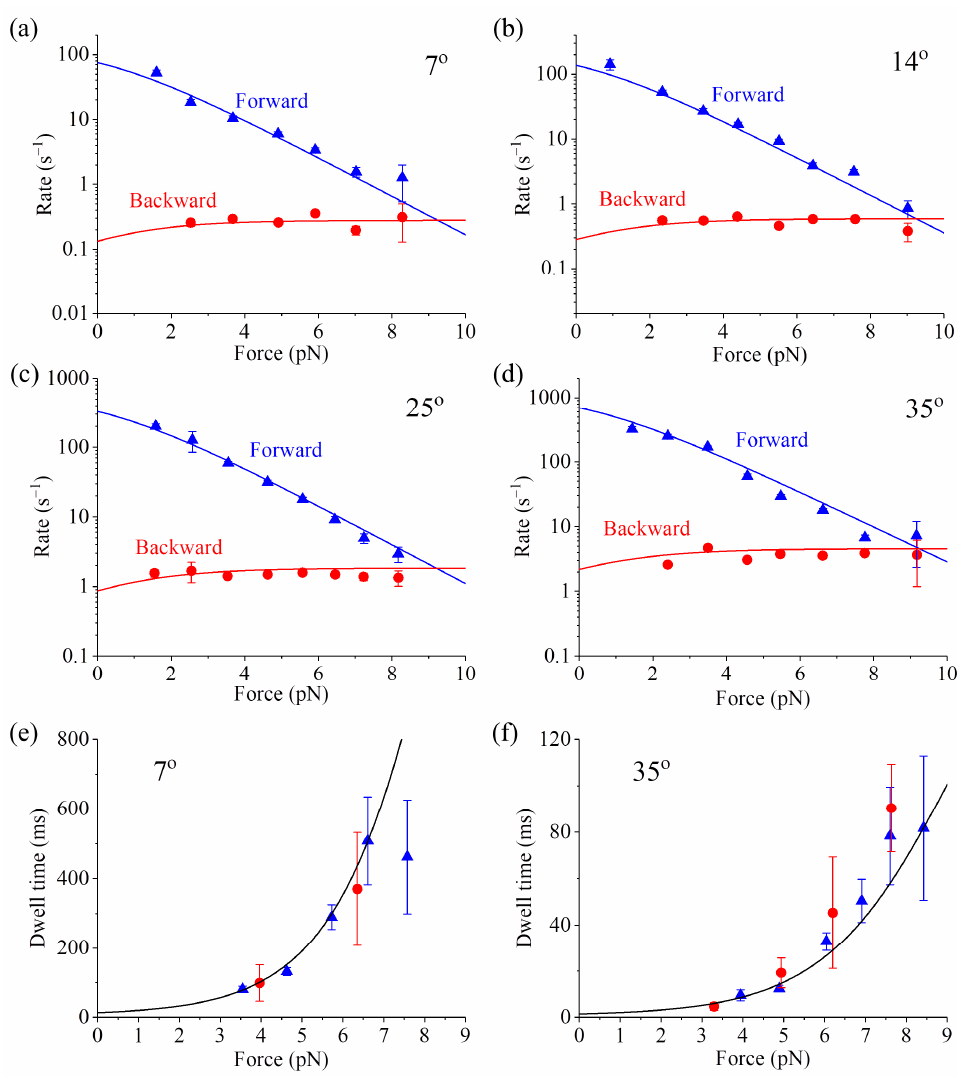
Figure 4. Thermodynamics of WT bovine brain kinesin-1 at saturating ATP. Lines represent analytical solutions. Symbols are experimental data at 1 mM ATP taken from Taniguchi et al. [59]. Adapted by permission from Springer Nature: Taniguchi, Y.; Nishiyama, M.; Ishii, Y.; Yanagida, T. Entropy rectifies the Brownian steps of kinesin. Nat. Chem. Biol. 2005 , 1 , 342–347. Licence number: 4680771382349. ( a – d ) Forward and backward stepping rates versus external force at di ff erent temperatures. ( e , f ) Dwell times between two mechanical steps versus external force at di ff erent temperatures. Blue and red symbols represent the experimentally measured dwell times for forward and backward steps, respectively.